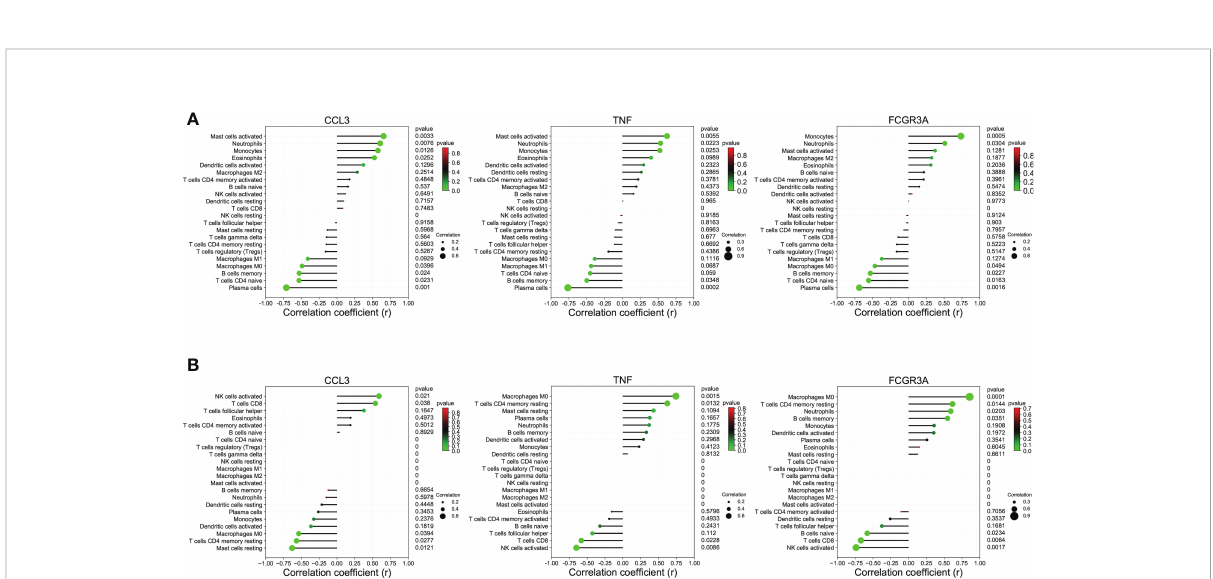
FIGURE 9 The association between key genes and immune cells. (A) CCL3, TNF, and FCGR3A were signi fi cantly associated with the primary in fi ltration cells of CU. (B) CCL3, TNF, and FCGR3A were signi fi cantly associated with the main in fi ltration cells of